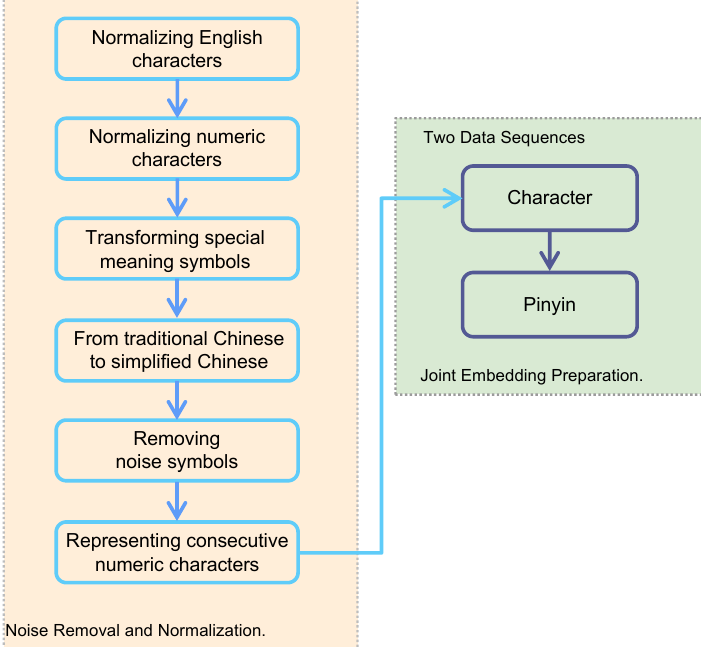
Figure 3. The data preprocessing